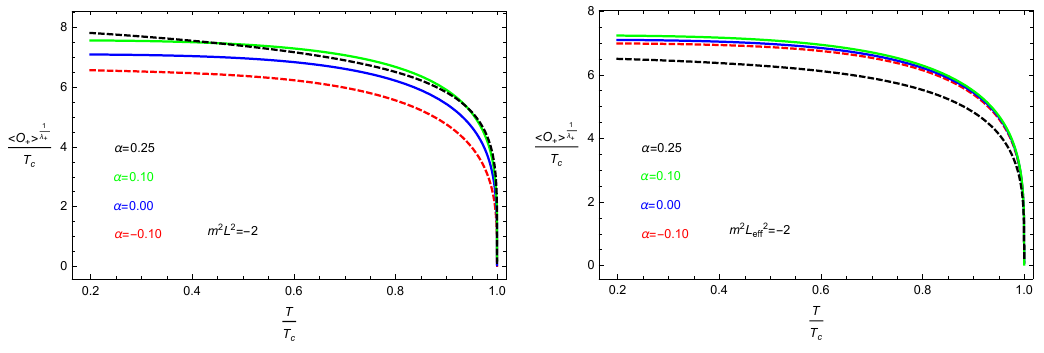
Figure 1 . The condensates of the scalar operator O + as a function of temperature for the fixed masses of the scalar field m 2 L 2 = − 2 (left) and m 2 L 2 parameters, i.e., α = − 0 . 1 (red and dashed), 0 . 0 (blue), 0 . 1 (green) and 0 . 25 (black and dashed), respectively.